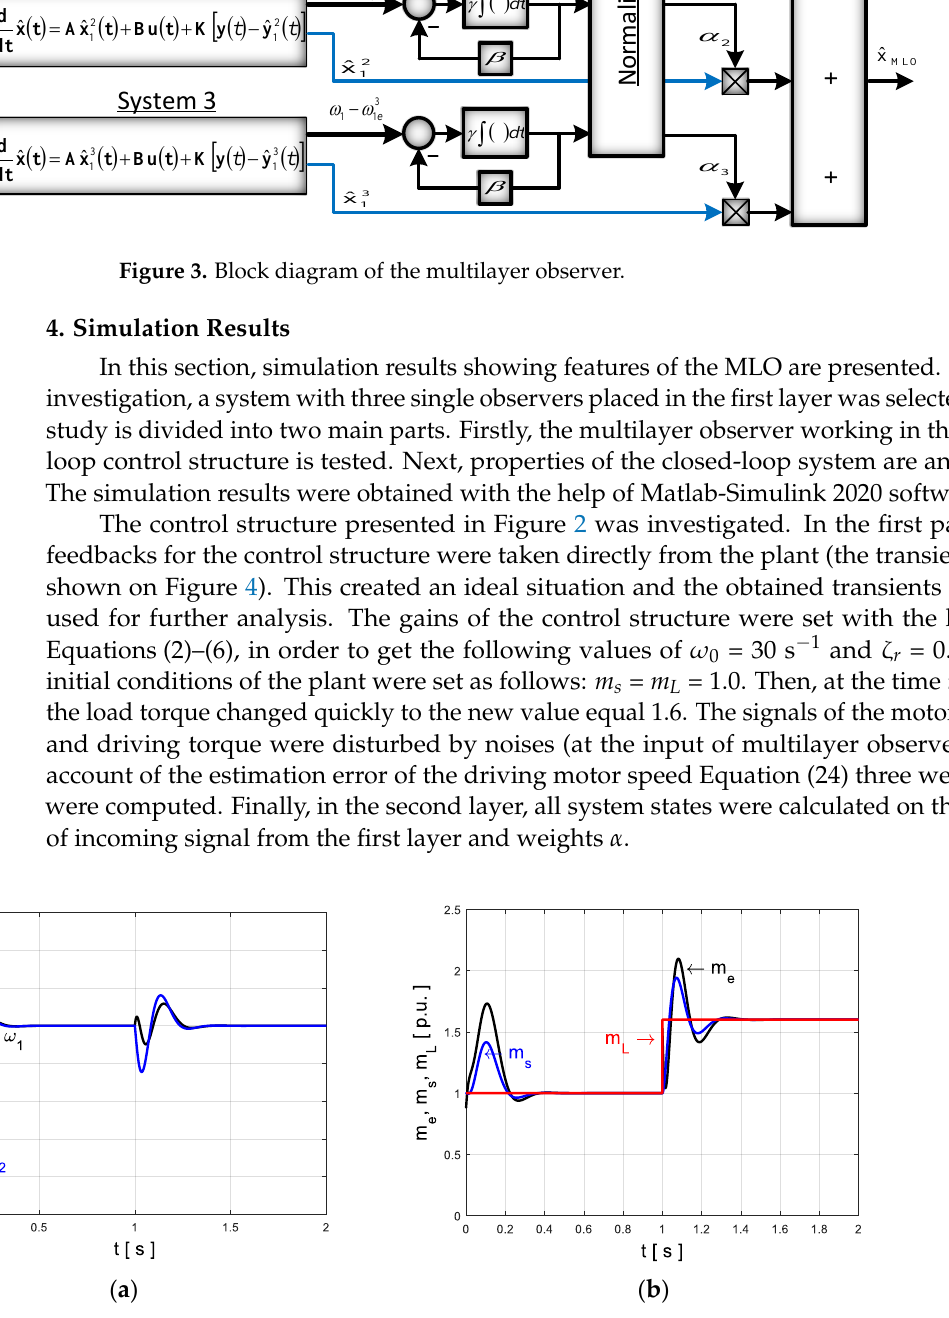
Figure 4. Transients of system states: driving motor and load machine speeds ( a ), electromagnetic (driving), shaft (torsional) and load (disturbance) torques ( b ), for the system working in closed-loop structure with direct information from state variables – simulation.